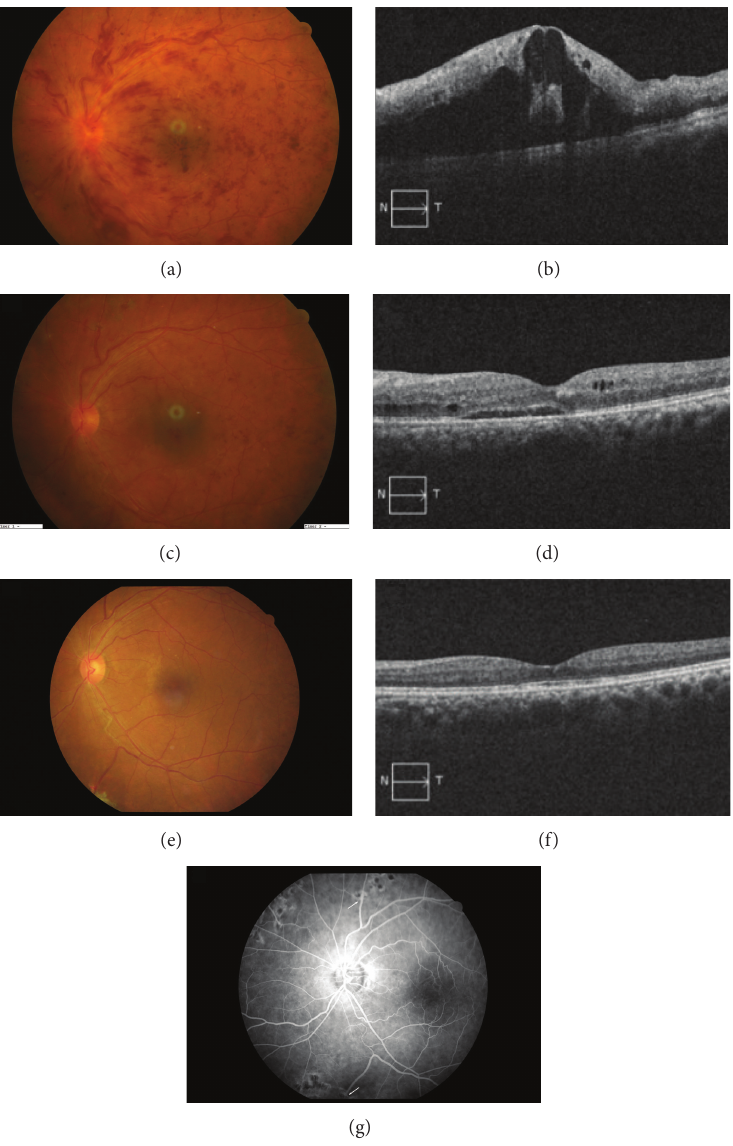
Figure 1: Preoperative fundus picture in patient 11 shows diffuse retinal hemorrhage and macular edema (a). Optical coherence tomography reveals macular thickening with cystic changes (b). Her corrected visual acuity was 20/400. Visible retinochoroidal anastomosis (c), decreased retinalhemorrhage,anddecreasedmacularedema(d)werenoted2monthsaftersurgery.Colorfundusphotography1yearaftersurgeryshows a total reabsorption of retinal hemorrhage (e). OCT demonstrates further decreased macular edema (f). Fluorescein angiography shows 2 well-established shunting sites ((g), arrows) and her corrected visual acuity was